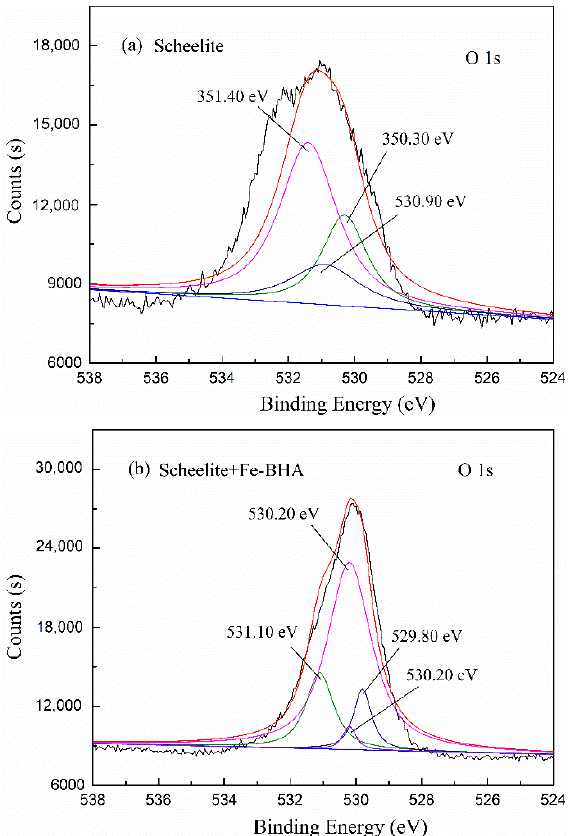
Figure 8. Ca 2p XPS spectra of scheelite ( a ) and scheelite conditioned with Fe-BHA ( b ).